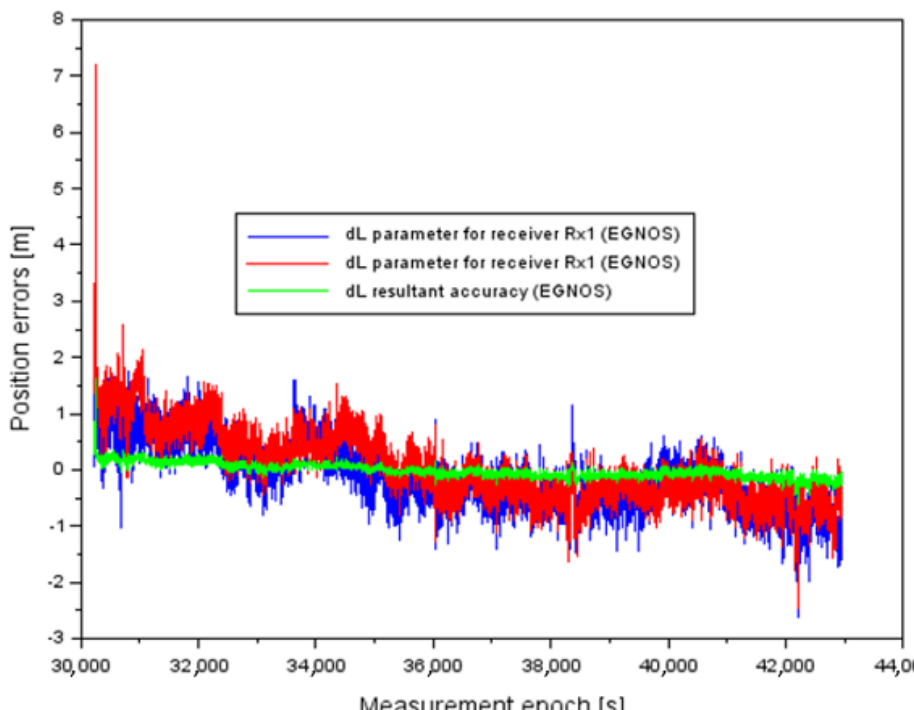
Figure 15. The results of 𝑑𝐿 position errors for EGNOS solution.